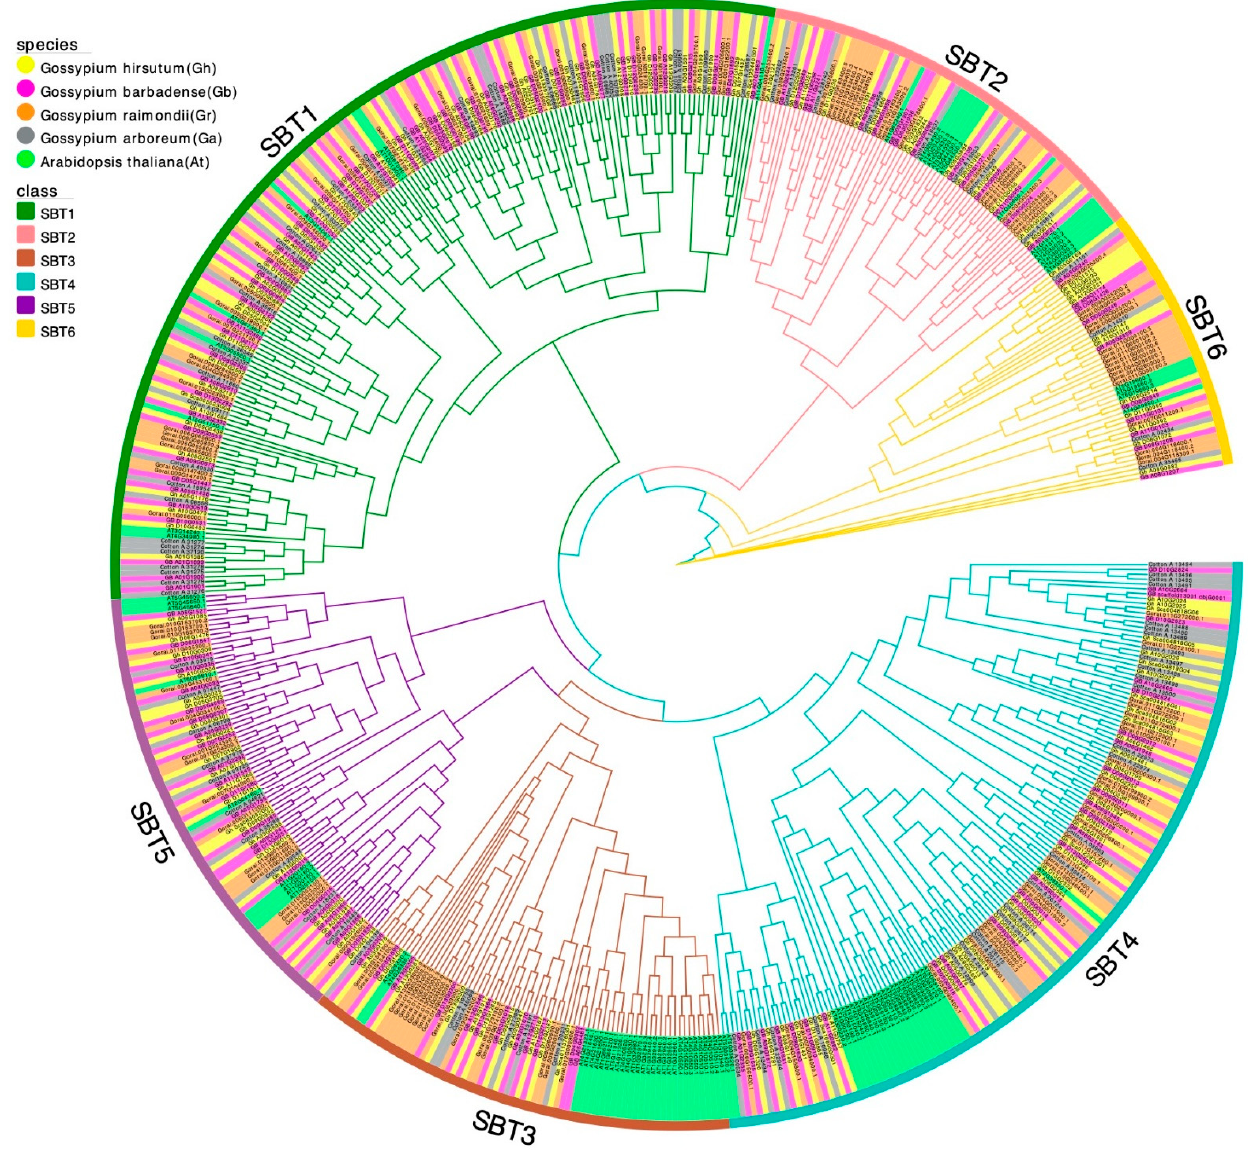
Figure 1. Phylogenetic relationships of SBT in different species. The circles around the phylogenetic tree (from center to periphery) represent each SBT subfamily and the distribution of species in different colors. Dark green, pink, brown, cyan, purple and dark yellow lines represent subfamilies from SBT1 to SBT6, respectively. Different gene names and background colors indicate different species. Yellow, dark pink, orange, grey and green indicate Gossypium hirsutum, Gossypium barbadense, Gossypium raimondii , Gossypium arboretum and Arabidopsis thaliana , respectively.